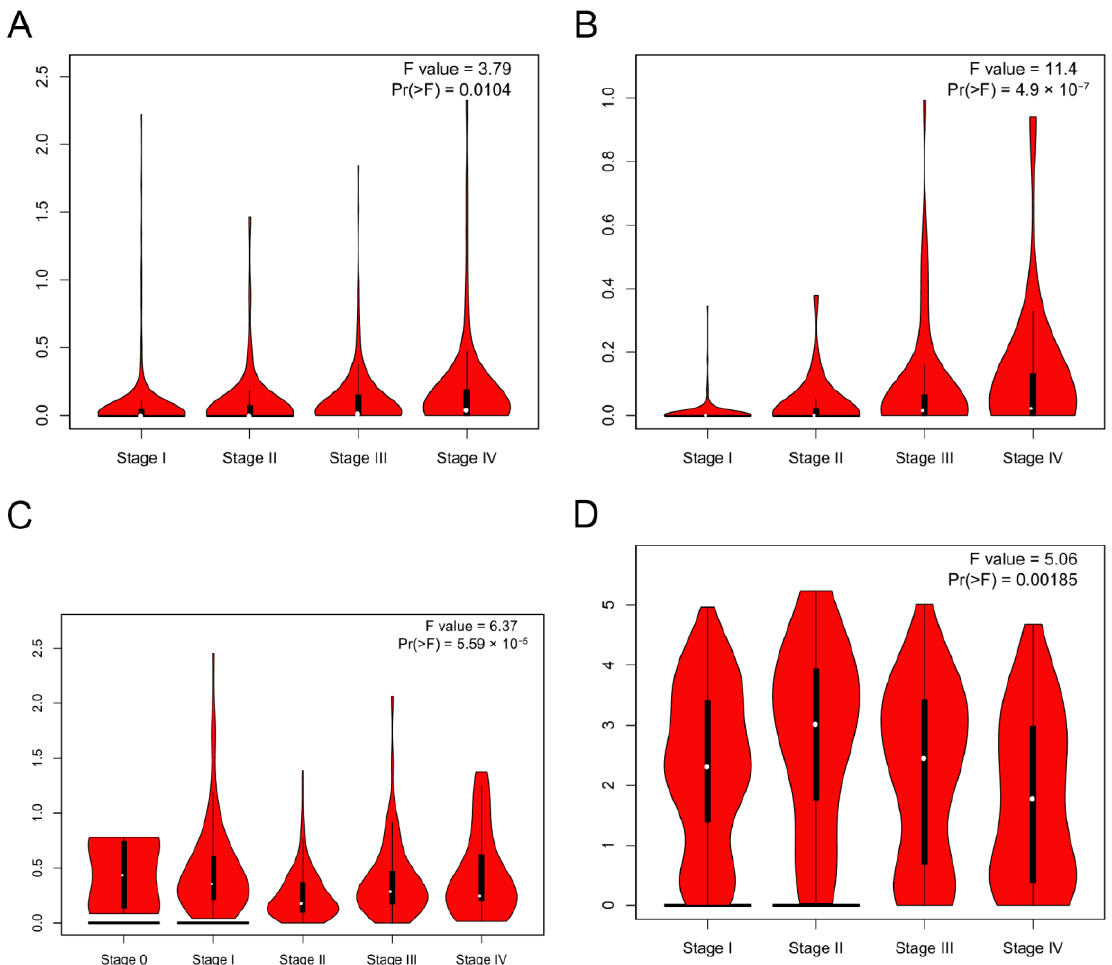
Figure 3. Correlation between the expression of DMRT3 in pan-cancer tumors and the pathological stage. ( A ) KIRC, ( B ) KIRP, ( C ) SKCM, and ( D ) THCA.